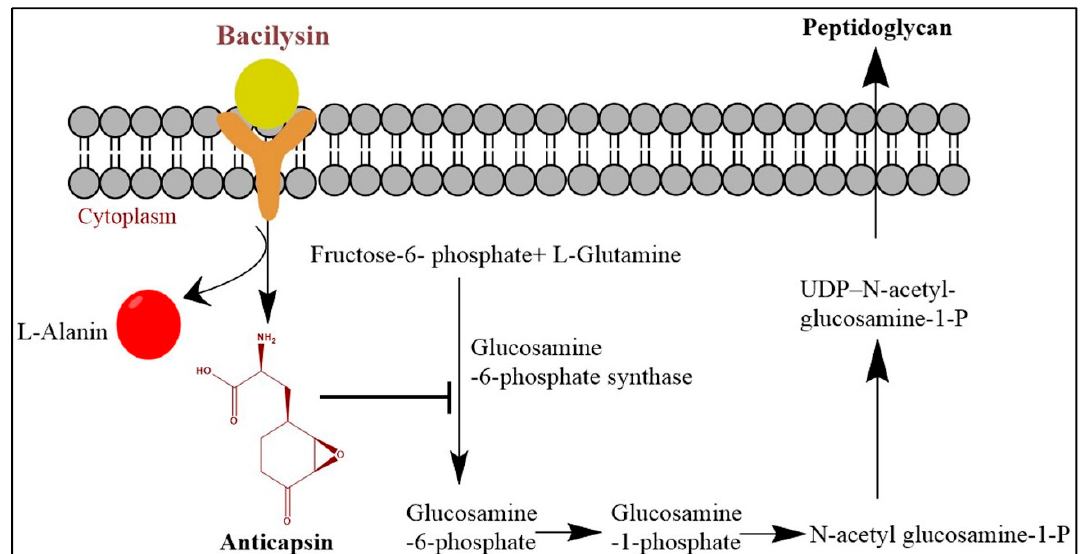
Figure 4. Modes of actions of antibacterial activity of bacilysin synthesized by B . velezensis .